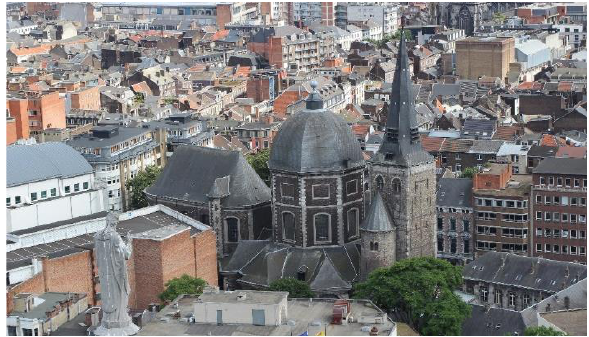
Figure 5. A view towards Saint John Church and cloister from the roof of Saint-Martin Church. Picture taken in 2016, by Cornélis Kill. This picture shows Saint John Church (left), its roman "avant-corps" partly dating back to the 11 th century (center) and its cloister (right).